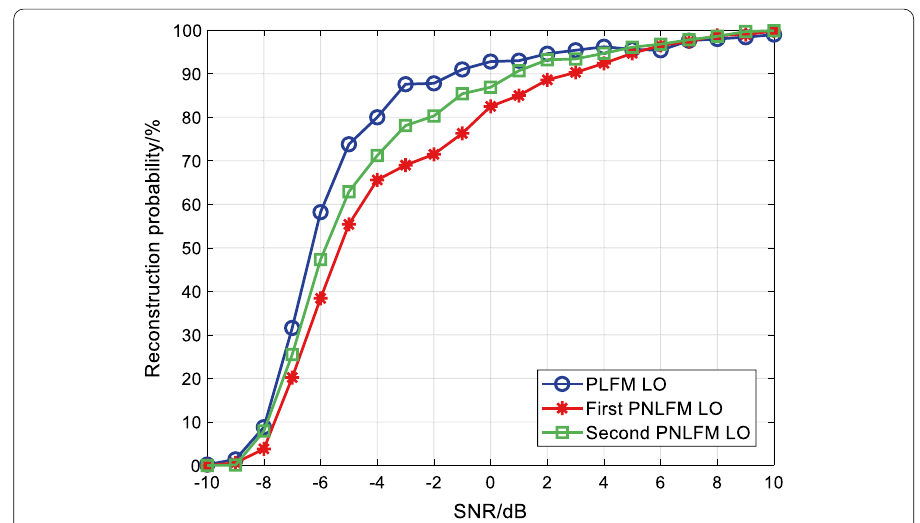
Fig. 8 Reconstruction probabilities using different LO modulation